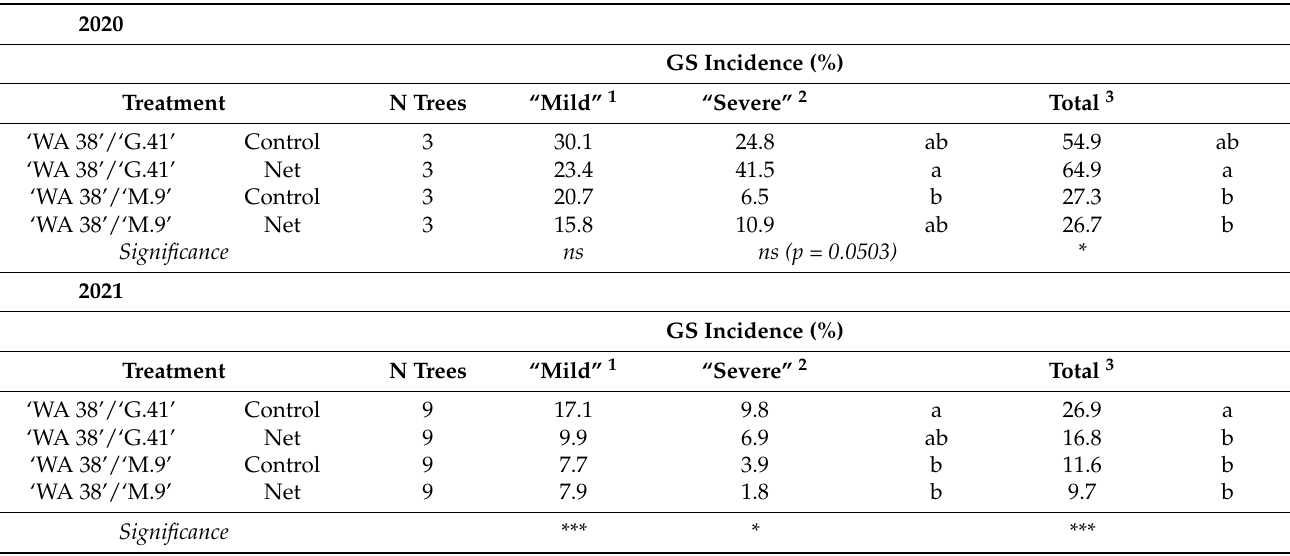
Table 2. Effect of rootstock and netting treatments on ‘WA 38” trees grafted on ‘Geneva 41’ (‘G.41’) and ‘Malling 9-Nic29’ (‘M.9’) rootstocks on the green spot (GS) incidence (%) in the 2020 and 2021 seasons. Significance by treatment combination: * = p ≤ 0.05; *** = p ≤ 0.001; ns = not